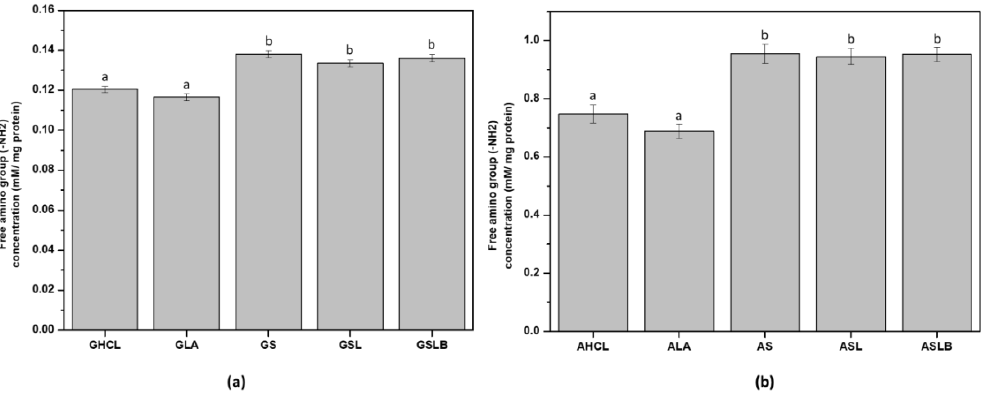
Figure 5. Free amino group content (mM/mg protein) of ( a ) globulin fractions obtained by controls (GHCl, GLA) and fermentations (GS, GSL, GSLB), ( b ) albumin fractions obtained by controls (AHCl, ALA) and fermentations (AS, ASL, ASLB). Different letter represents significant differences among different samples (Turkey’s post hoc test).